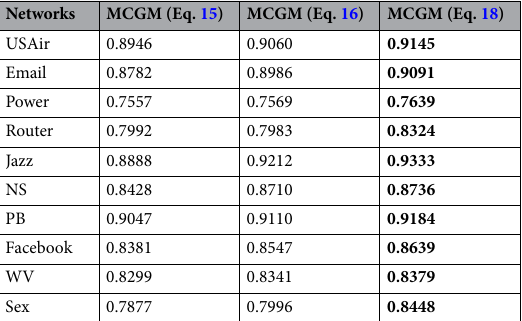
Table 6. The algorithms’ accuracies of MCGM using Eq. (15), MCGM using Eq. (16) and MCGM using Eq. (18) measured by Kendall’s Tau for β = β c . The parameters are adjusted to their optimal values subject to the largest τ . For each network, the best algorithm is emphasized by bold.